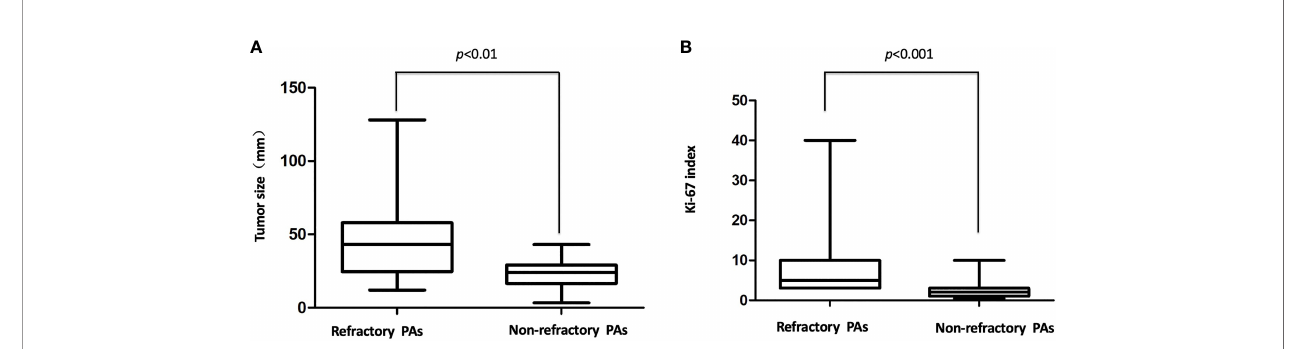
FIGURE 1 | (A) Tumor size in the refractory and nonrefractory groups. There was a signi fi cant difference in the size of the refractory versus nonrefractory tumors (48.6 vs. 22.6 mm, p < 0.01 (B) , The Ki-67 index in the refractory and nonrefractory groups. There was a signi fi cant difference in the Ki-67 index of the refractory versus nonrefractory tumors (6.9% vs. 1.2%, p